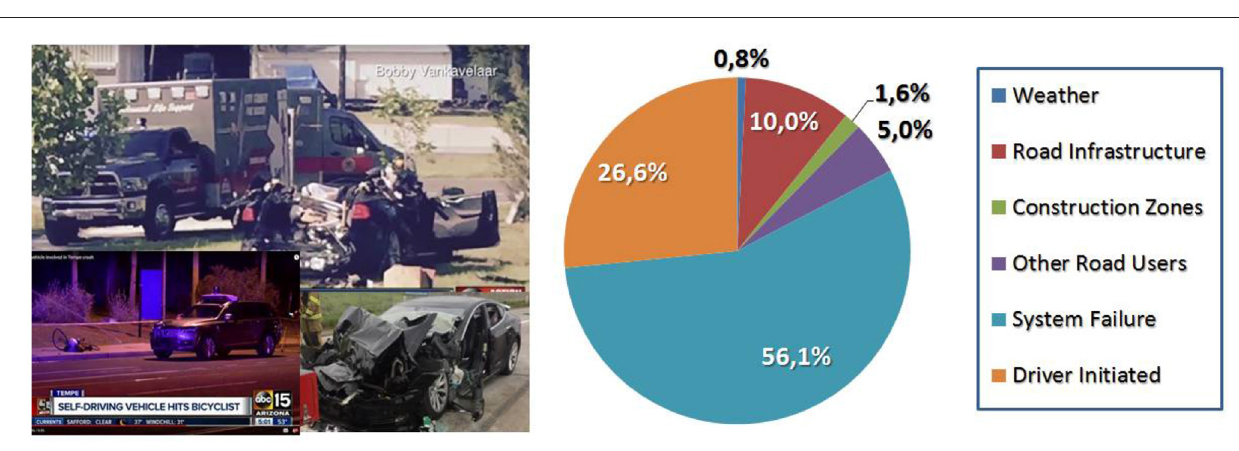
FIGURE 8 | AVs crashes and identification of the